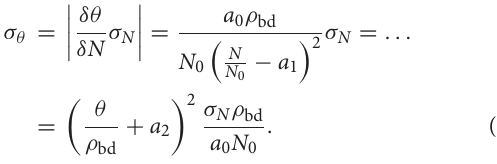
Frontiers in Water |